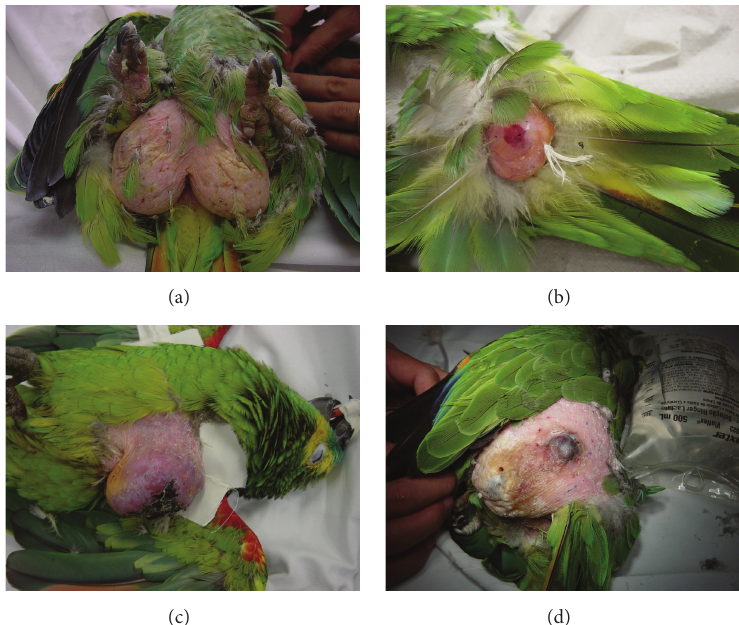
Figure 3: Neoplasms affecting the integumentary system of birds in the genus Amazona. (a) Pericloacal lipoma ( A. aestiva ). (b) Lipoma affecting the dorsal area near the tail ( Amazona sp . ). (c) Cutaneous lymphoma ( A. aestiva ). (d) Well-differentiated hemangiosarcoma affecting the pelvic limb ( A. aestiva ).